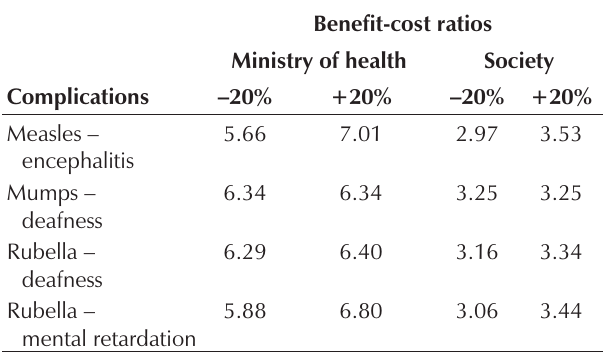
Benefit-cost ratios for sensitivity analysis of the probabilities of the most expensive complications of measles, mumps and